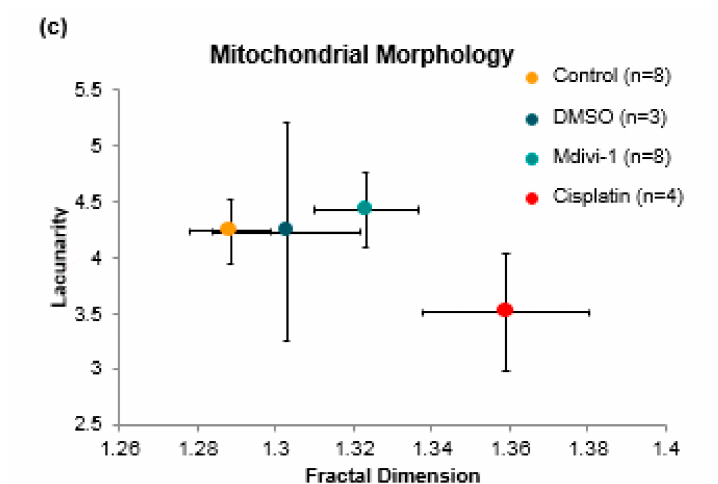
Figure 3. Mitochondrial protein expressions, immunofluorescence images, and fractal analysis of SCLC cell lines. ( a ) Representative immunoblots showing expression of mitochondrial proteins in a panel of SCLC cell lines. Protein loading was normalized by measurement of protein concentration. Three independent replicate experiments were performed. The full western blots are visualized in Supplementary Figure